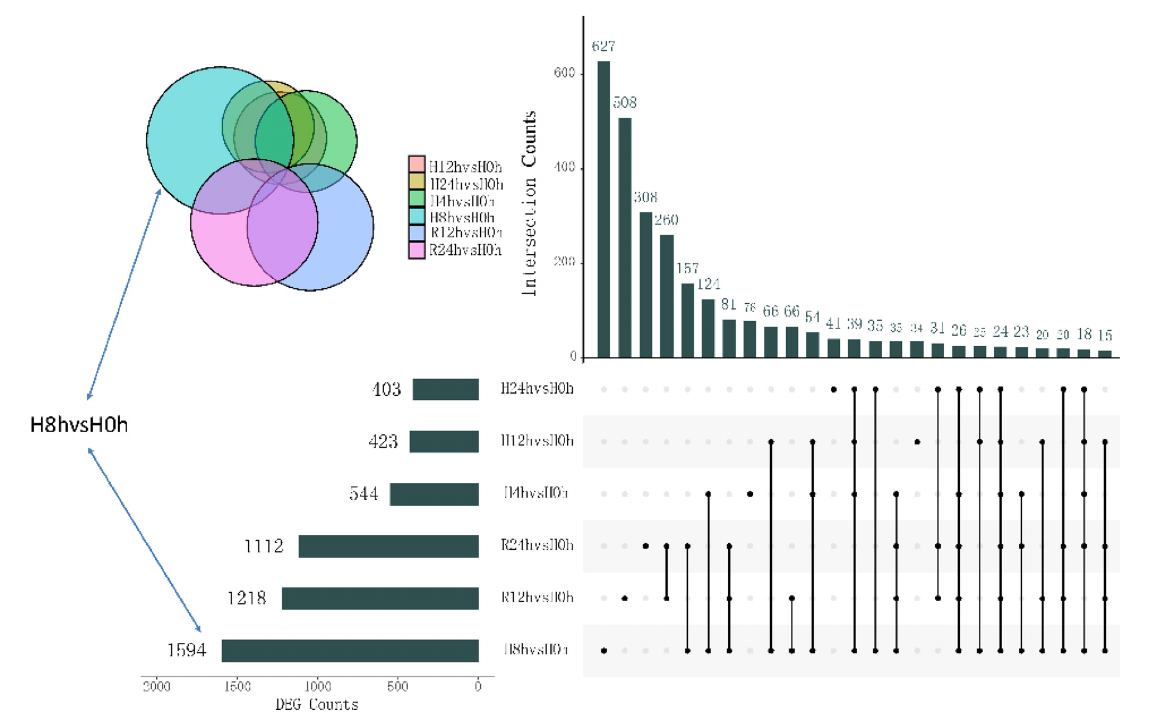
activity. No KEGG pathways were found for the URGs. A total of six GO terms, including three BPs and three MFs, were significantly enriched for the DRGs. The GO terms associated with small-molecule metabolic process and transferase activity were significantly enriched ( Figure 4D ). The DRGs were